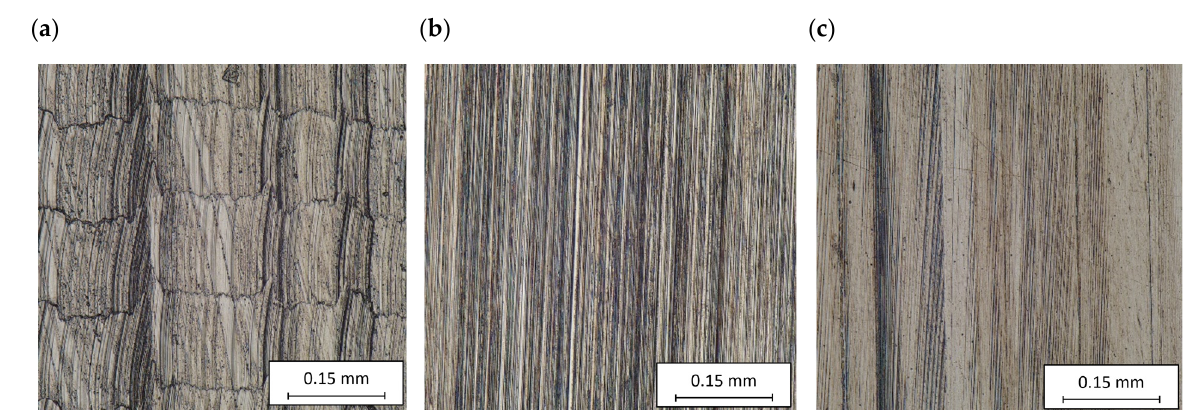
Figure 12. Microscopic view of the machined surface: ( a ) view of the surface in its initial state after shape milling at 400× magni fi cation; ( b ) view of the surface after shape milling and rough grinding at 400× magni fi cation; ( c ) view of the surface after shape milling, rough grinding and fi nish grinding at 400× magni fi cation.